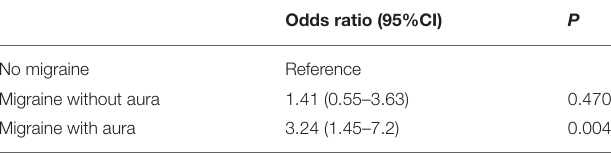
TABLE 3 | Multinomial logistic regression of the association between migraine without aura and migraine with aura, with possibly causal PFO after adjustment on age, sexe and atherosclerosis, and small vessel